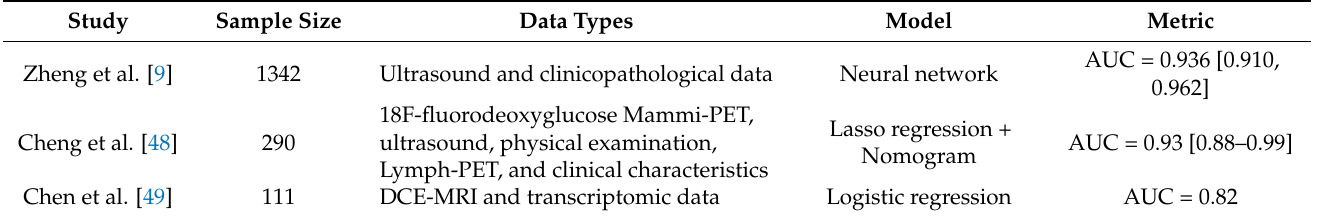
Table 5. Summary of studies combining radiomics and clinicopathological features for breast cancer lymph node